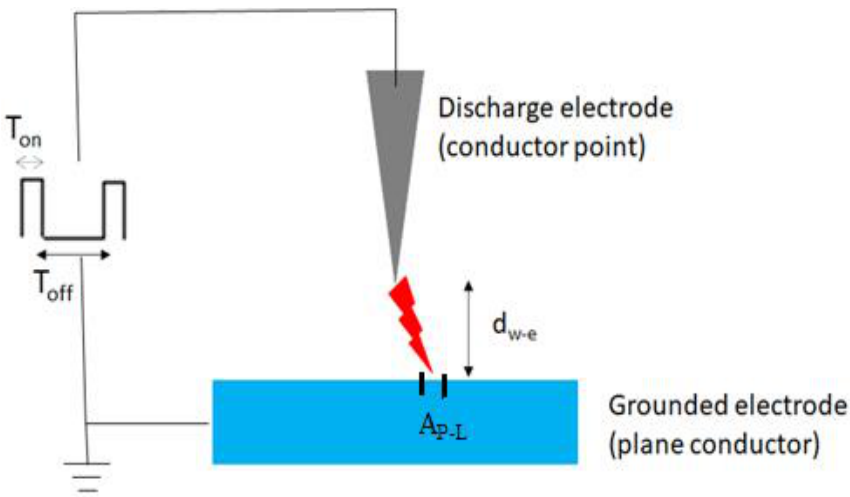
Figure 5. Schematic configuration of a corona discharge.